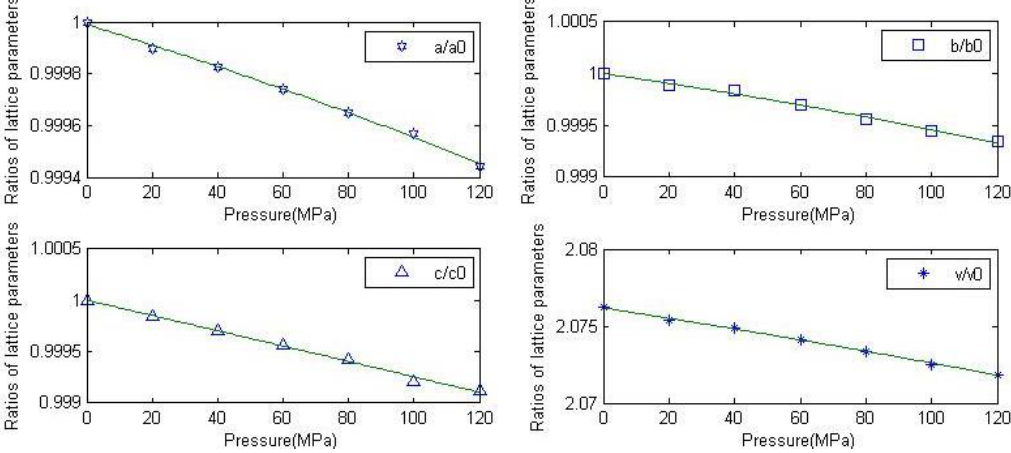
Figure 3. Fitting function curves of the lattice constant of anhydrite.